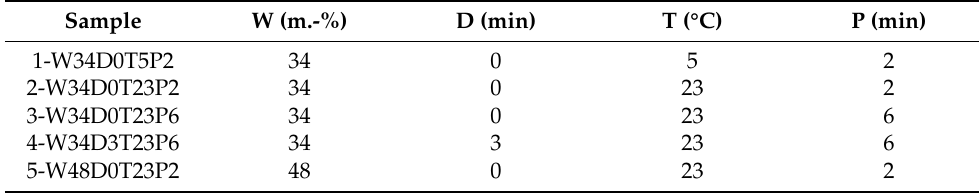
Table 1. Parameter configuration of the investigated freeze